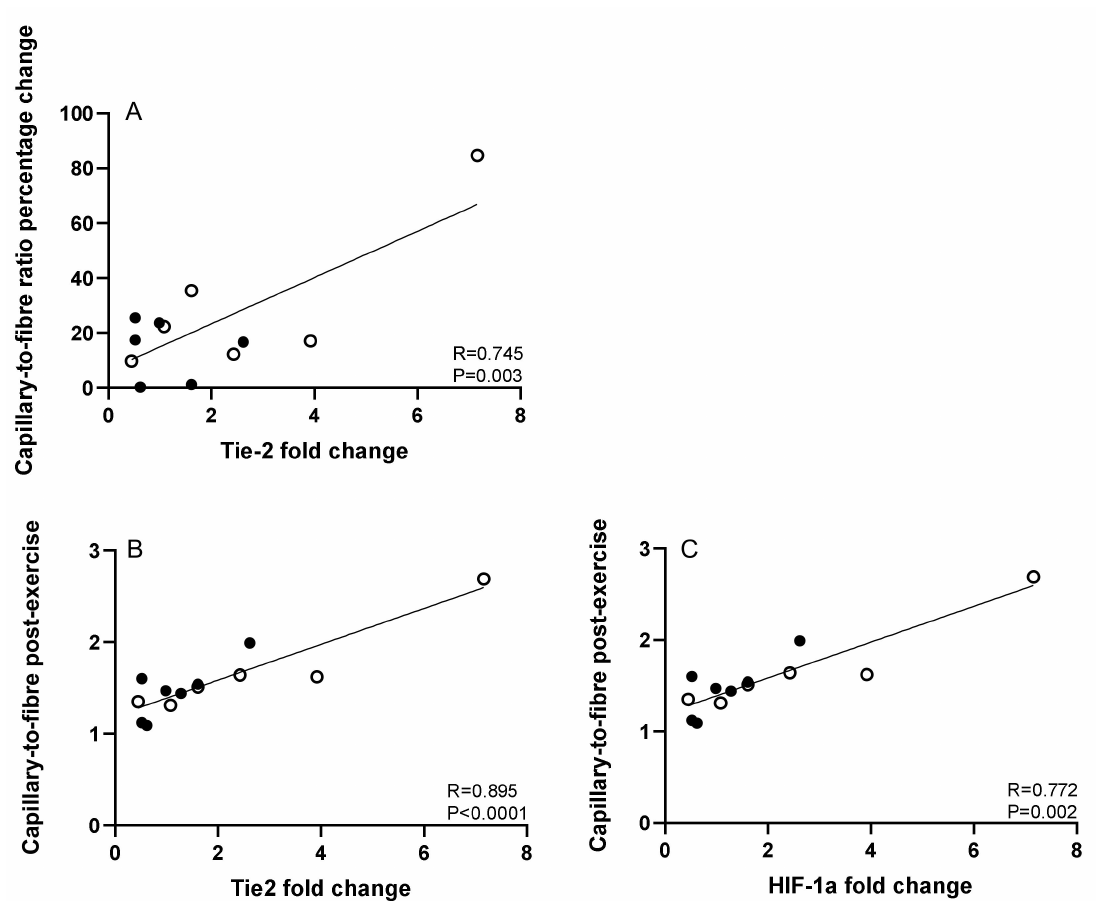
Figure 2. Associations between the fold change of Tie2 receptor expression ( A ) and the capillary-to-fibre ratio percentage change (%) and the absolute number of capillary-to-fibre ratio post-exercise training ( B ), as well as between the fold changes of HIF-1 α expression and the absolute number of capillary-to-fibre ratio post-training ( C ) in skeletal muscles of the total number of HF patients [total N = 13; HIIT N = 6 (open cycles); and COM N = 7 (filled